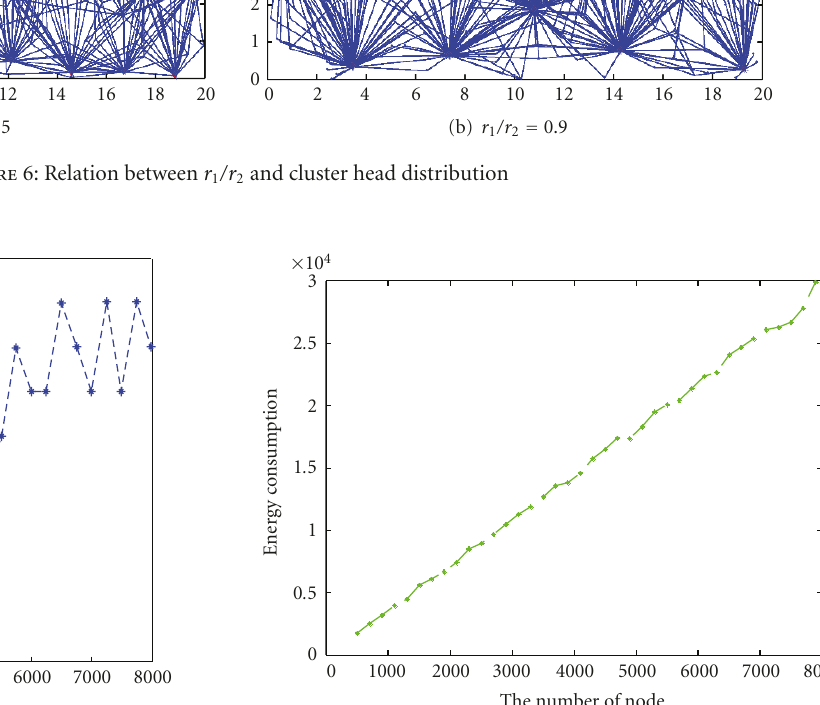
Figure 7: Relation between node density and number of cluster heads. Figure 8: Relation between total energy consumption and number